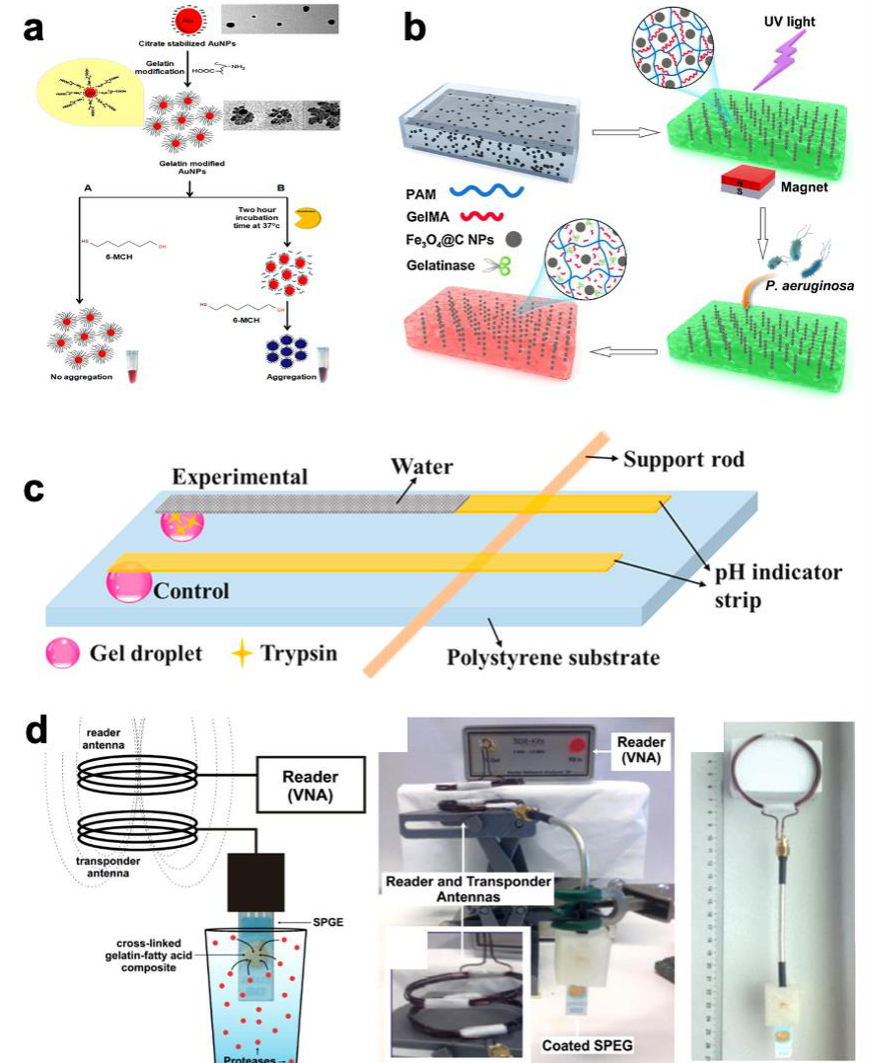
Figure 3. Biosensors for medical diagnosis with gelatin as bio-recognition materials. ( a ) The principle of gelatin-modified AuNP-based colorimetric assay for direct detection of total gelatinase activ- ity [86] (copyright (2016) Elsevier B.V.); ( b ) schematic illustration showing the structural design and responsive mechanism of the photonic hydrogels for visual detection of P. aeruginosa [88] (copyright (2020) Elsevier B.V.); ( c ) schematic diagram of the developed sensor for the detection of trypsin [90] (copyright (2021) Elsevier B.V.); ( d ) illustration and photograph of the setup used for wireless protease detection [92] (copyright (2020) American Chemical Society).